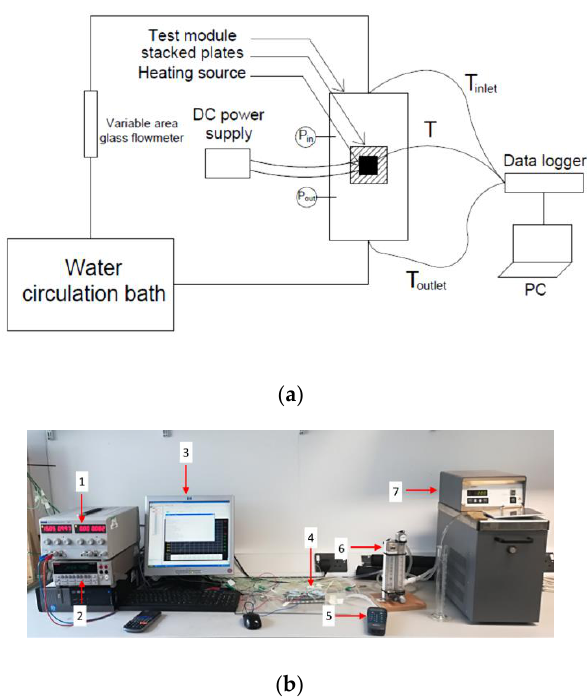
Figure 1. ( a ) Experiment setup schematic; ( b ) photograph of the experimental set-up; (1) DC power supply, (2) data logger, (3) personal computer, (4) test module, (5) differential pressure meter, (6) variable area glass flowmeter, (7) water circulation bath.